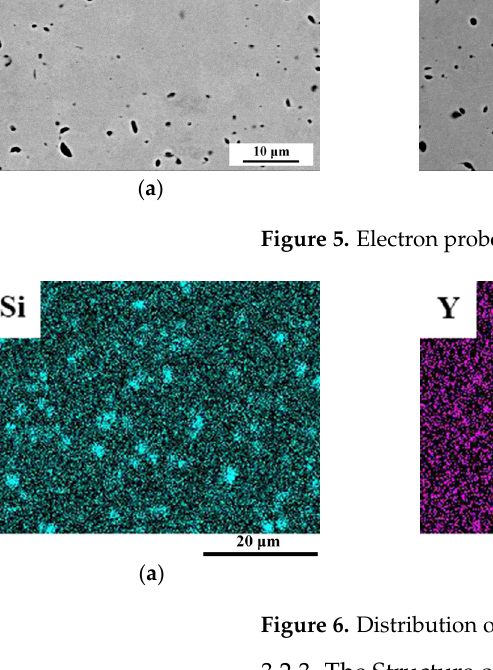
Figure 5. Electron probe maps of ( a ) 1280-S1, ( b ) 1280-S2 and ( c ) 1280-S3 ODS steels.